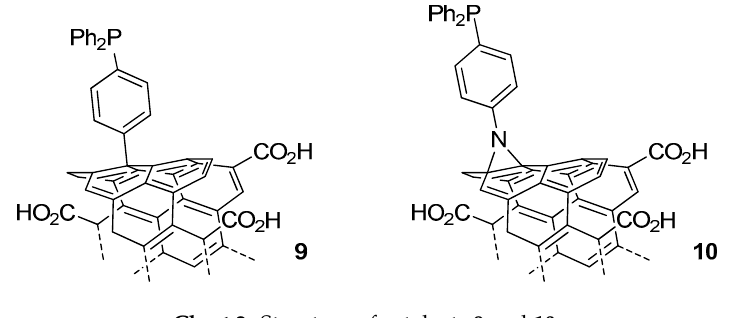
Table 2. X-ray Photoelectron Spectroscopy (XPS) semi-quantitative analysis of 8 dropcasted on